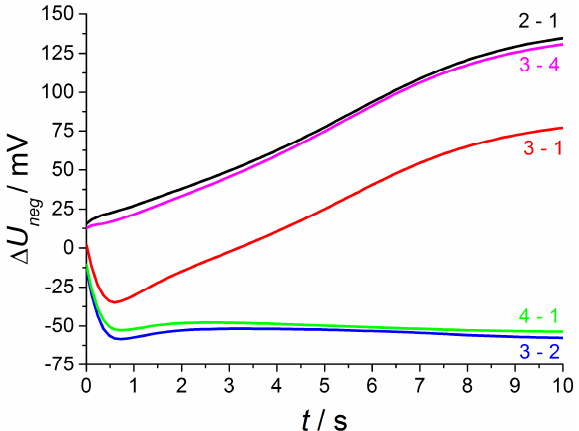
Figure 10. Voltage difference ∆ U between different phases of NO presence on both